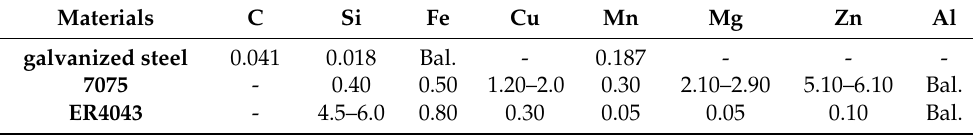
Table 1. Nominal chemical composition of base materials and filler wire (wt.%).